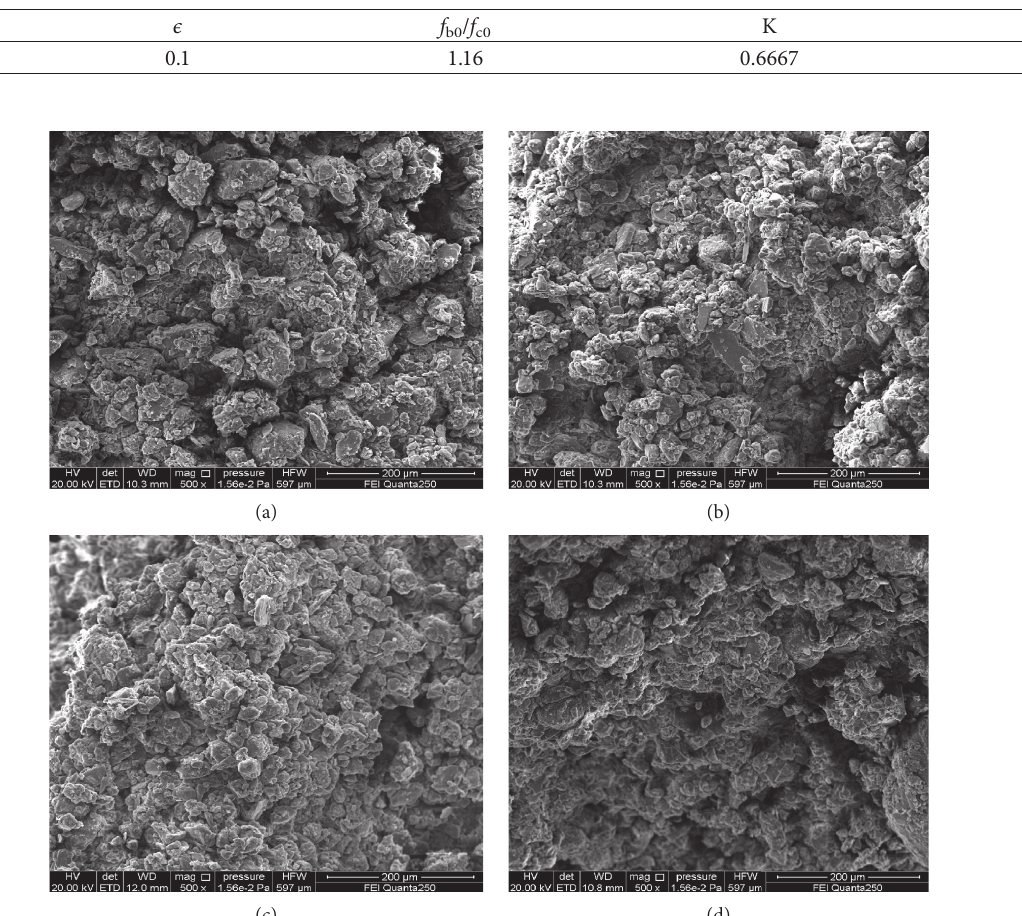
Figure 10: SEM image of Zhouqiao earthen soil: (a) SEM image 1, (b) SEM image 2, (c) SEM image 3, and (d) SEM image 4.